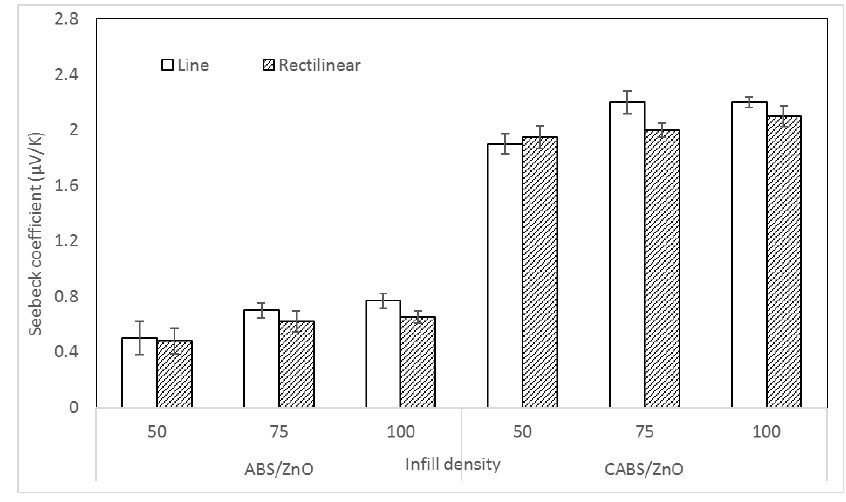
Figure 12. Seebeck coefficient of ABS composites with different infill density and printing pattern.